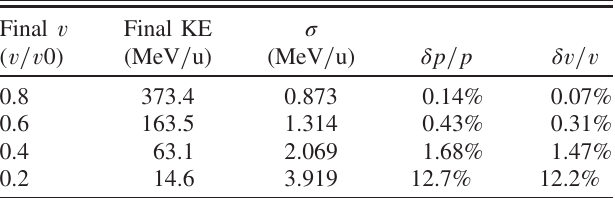
TABLE IV. The σ of energy straggling for 1 GeV = u 238 U ions passing through a C target with the specified energy losses, calculated by the code ATIMA